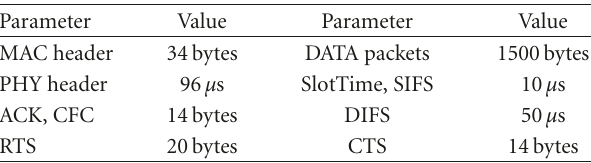
Table 1: System parameters.